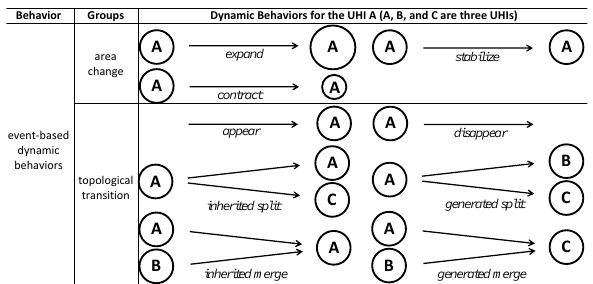
Figure 1: Definition of the dynamic behaviors of an UHI